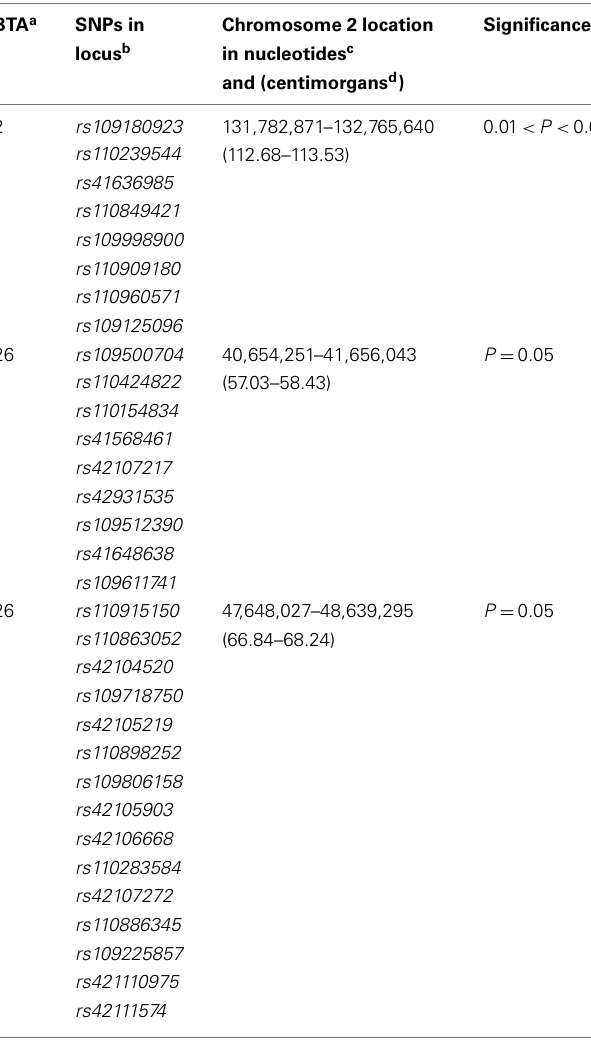
Table 5 | Loci linked with bovine respiratory disease on BTA2 and BTA26 in a half-sibling Brangus and a half-sibling Braford